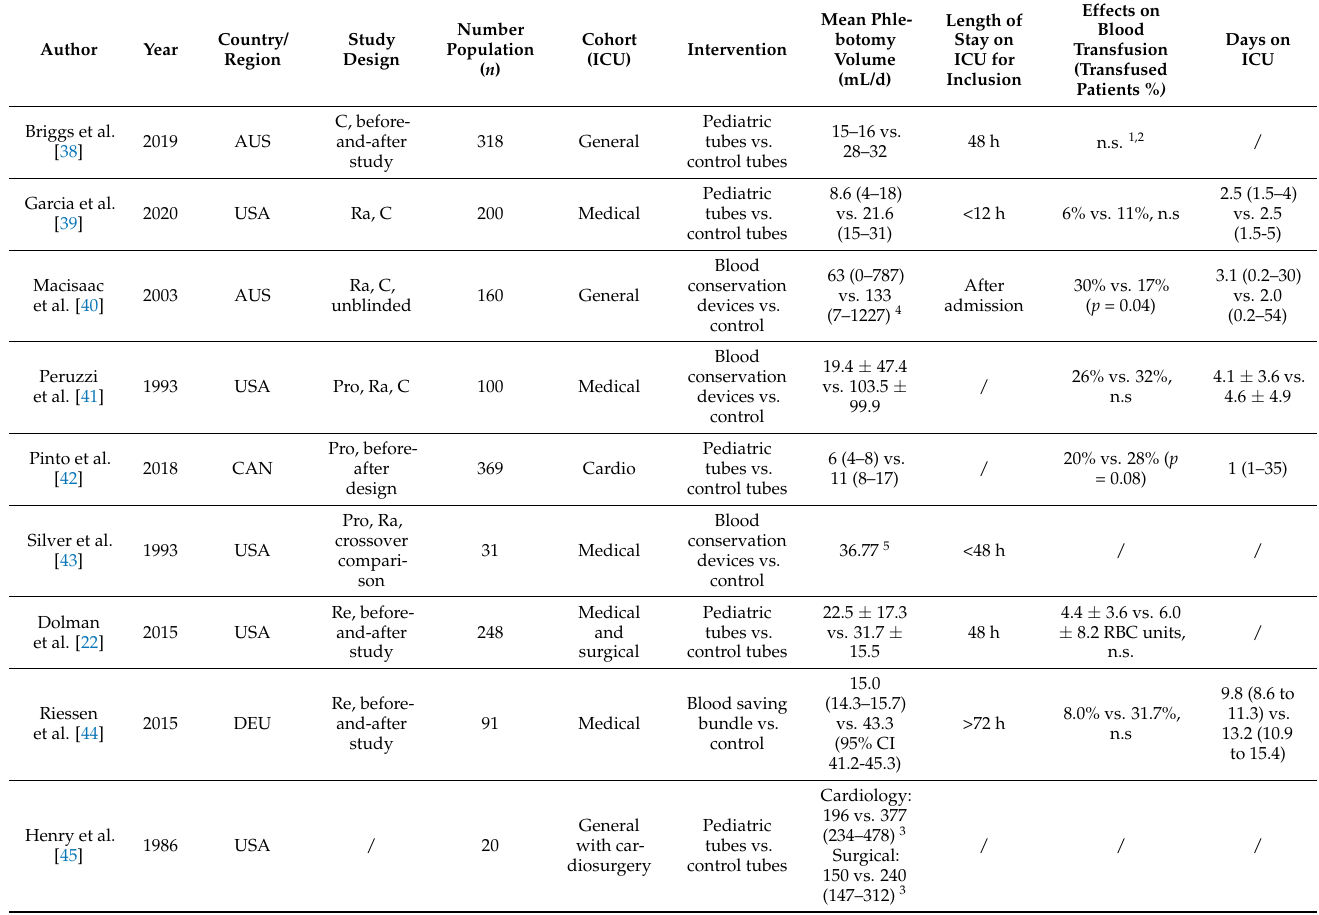
Table 2. Interventional